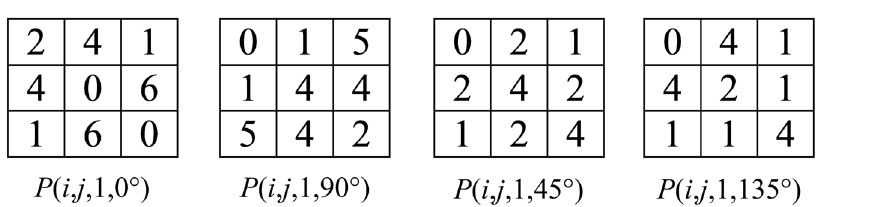
Figure 3. Symmetric GLCM examples of the sample image.